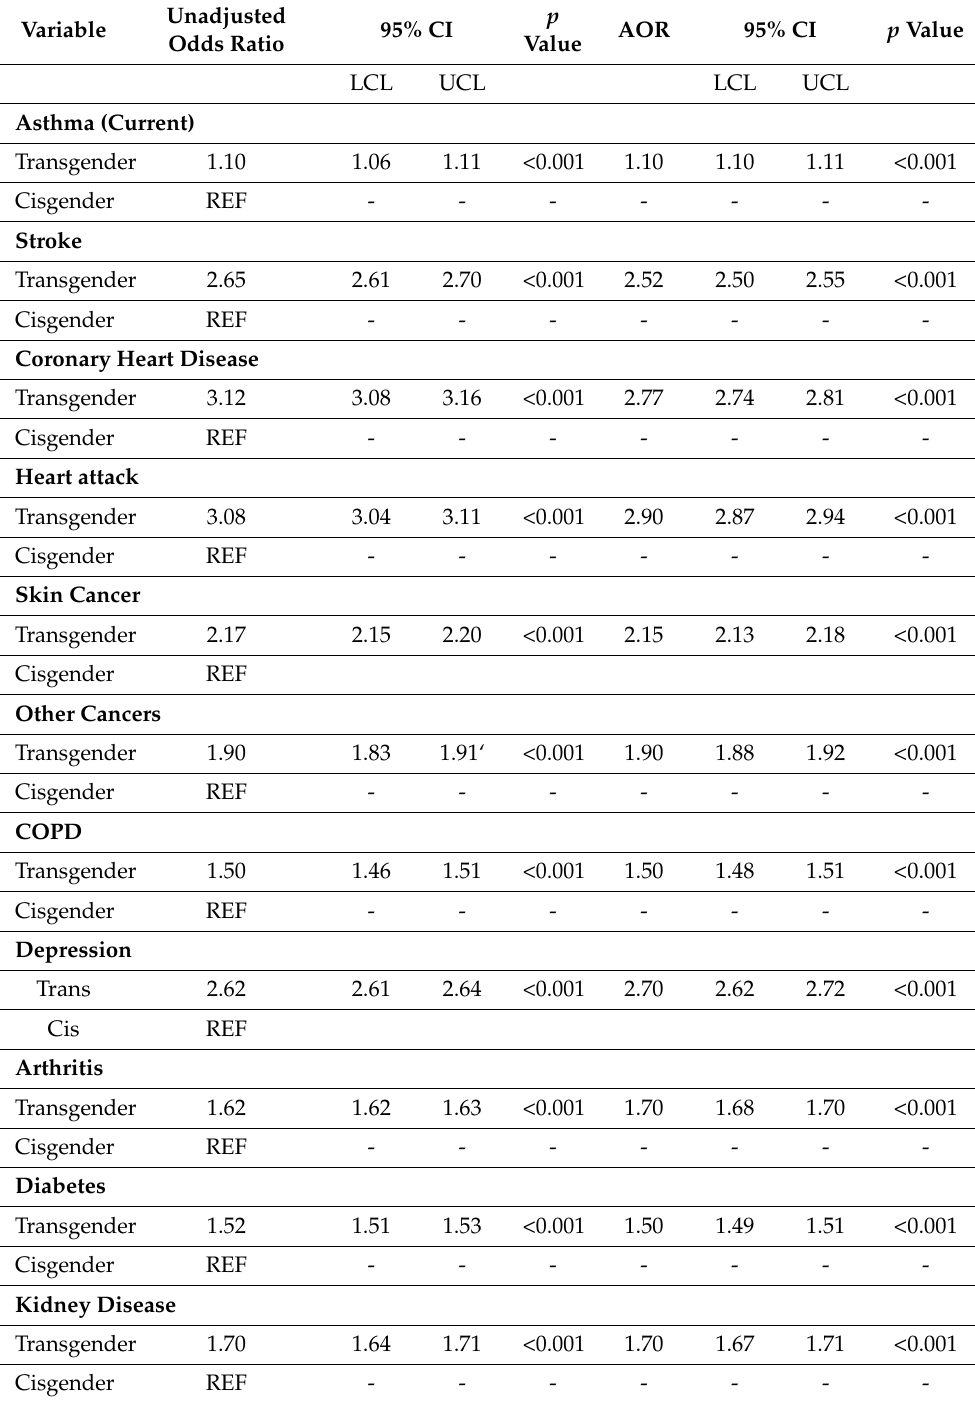
Table 5. Adjusted and unadjusted odds ratio for chronic health conditions among matched samples.